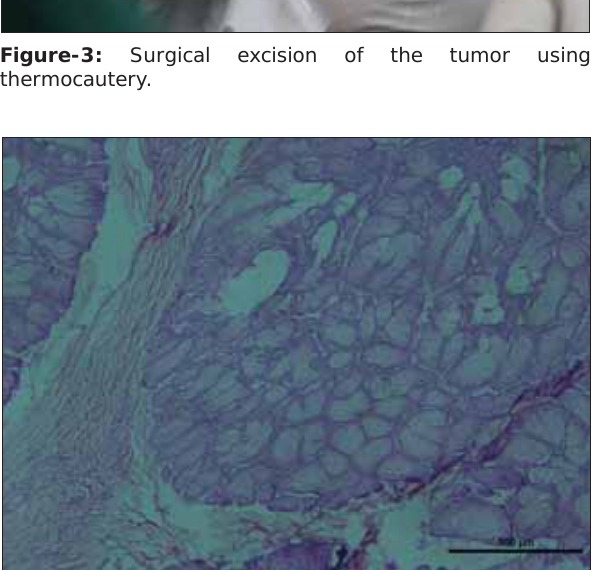
Figure-4: Large mature sebaceous cells (sebocytes) at the center and undifferentiated basaloid cells at the periphery characteristic of sebaceous adenoma (500 μ